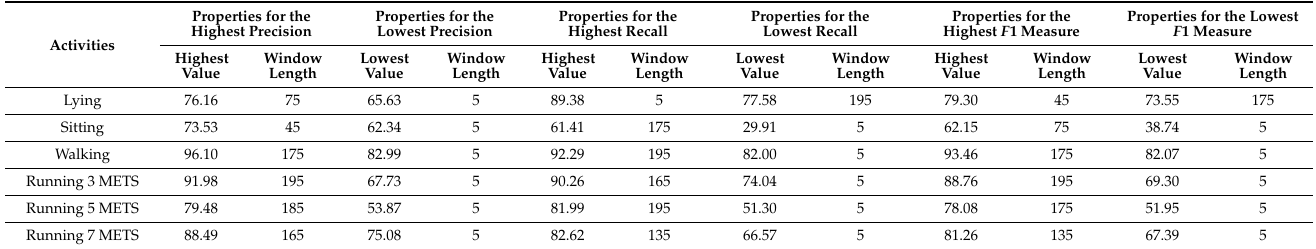
Figure 10. Precision, recall, and f1 measure for each activity class at different window lengths. Table 6. Highest and lowest averaged precision, recall, and f1 measure for each activity and respective window